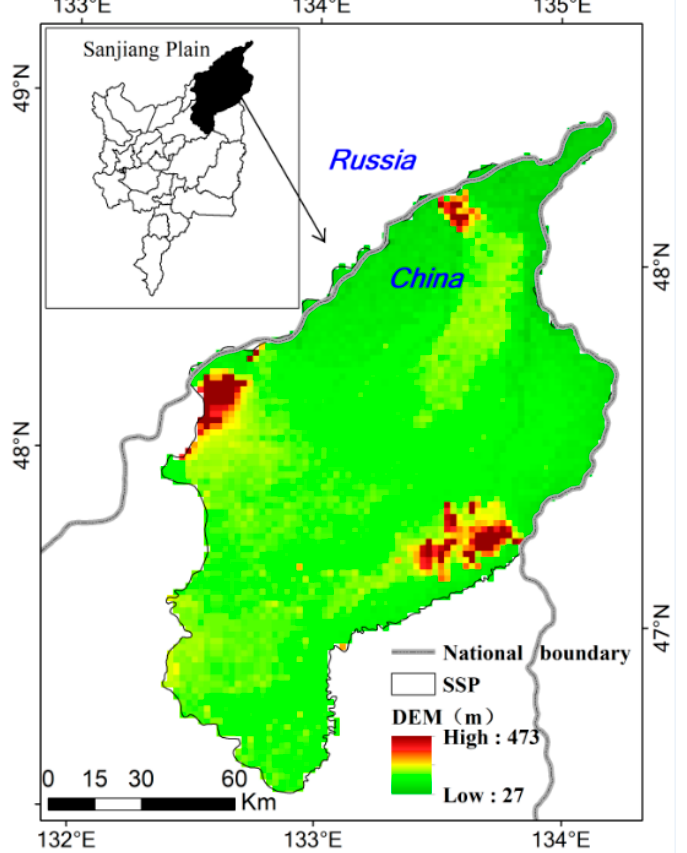
Figure 1. The study area. SSP, Small Sanjiang Plain.